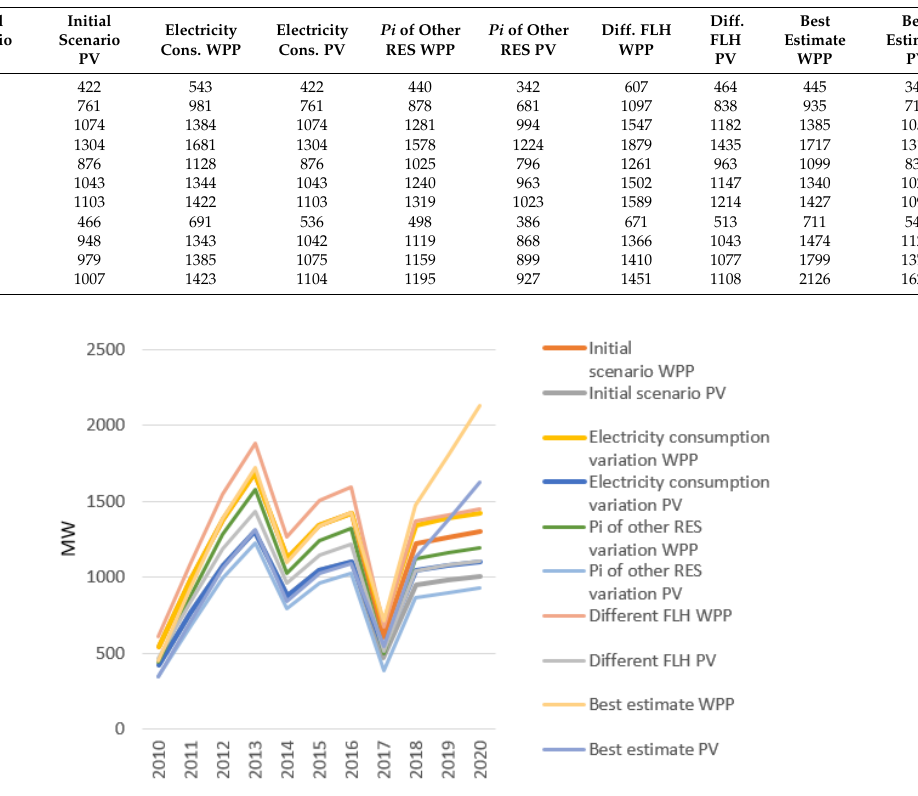
Figure 5. Simulation of different scenarios of wind energy integration.